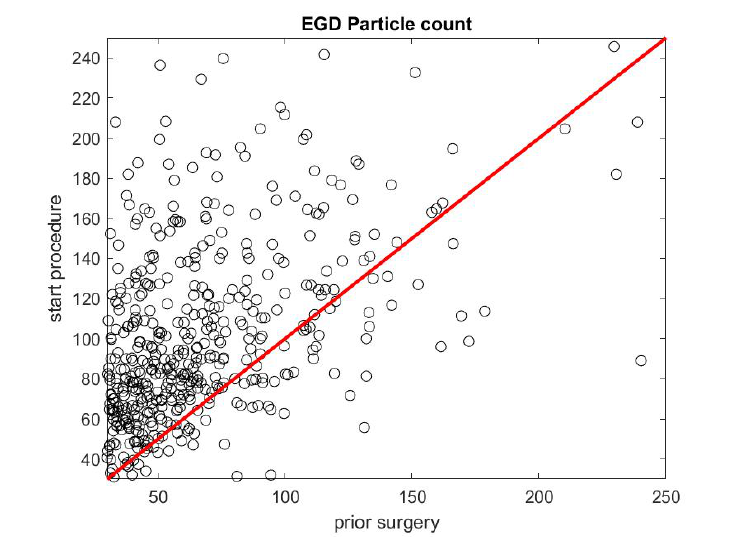
versus the particle count in the 5 min start